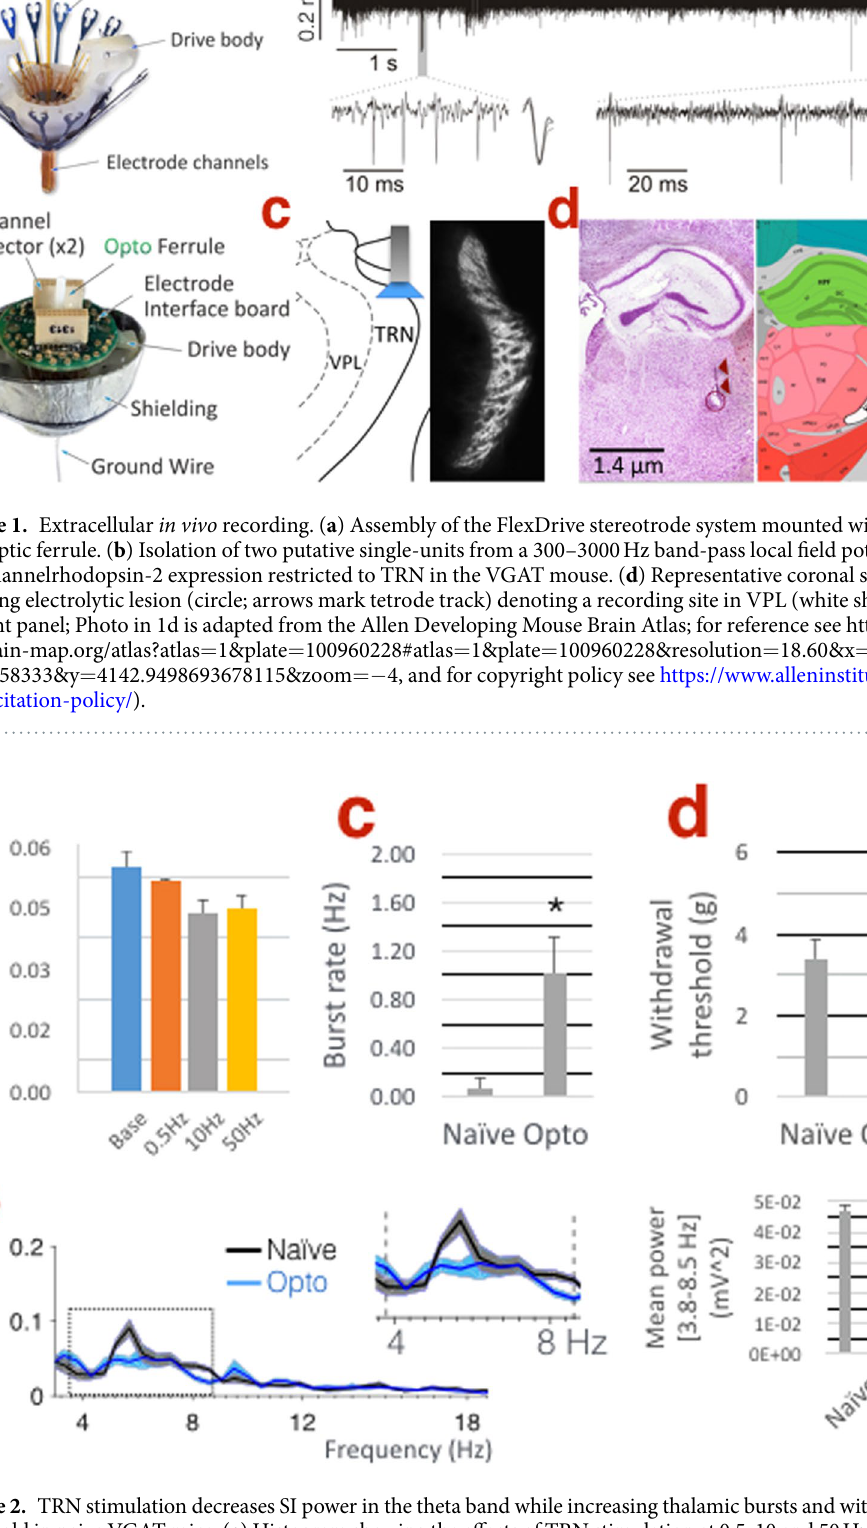
Figure 2. TRN stimulation decreases SI power in the theta band while increasing thalamic bursts and withdrawal threshold in naive VGAT mice. ( a ) Histogram showing the effects of TRN stimulation at 0.5, 10 and 50 Hz on mean theta (4–8 Hz) power under 1.5% isoflurane sedation (n = 2 mice). ( b ) SI power spectra. Inset in right panel shows significant decrease in power within the theta band (3.8–8.5 Hz) following 10 Hz TRN stimulation in awake mice (n = 5 mice). ( c ) TRN stimulation increases burst firing in VPL neurons (n = 17 units, 3–4 units per mouse; 5 mice) and increases the threshold of mechanical withdrawal to von Frey stimuli ( d ; n = 4